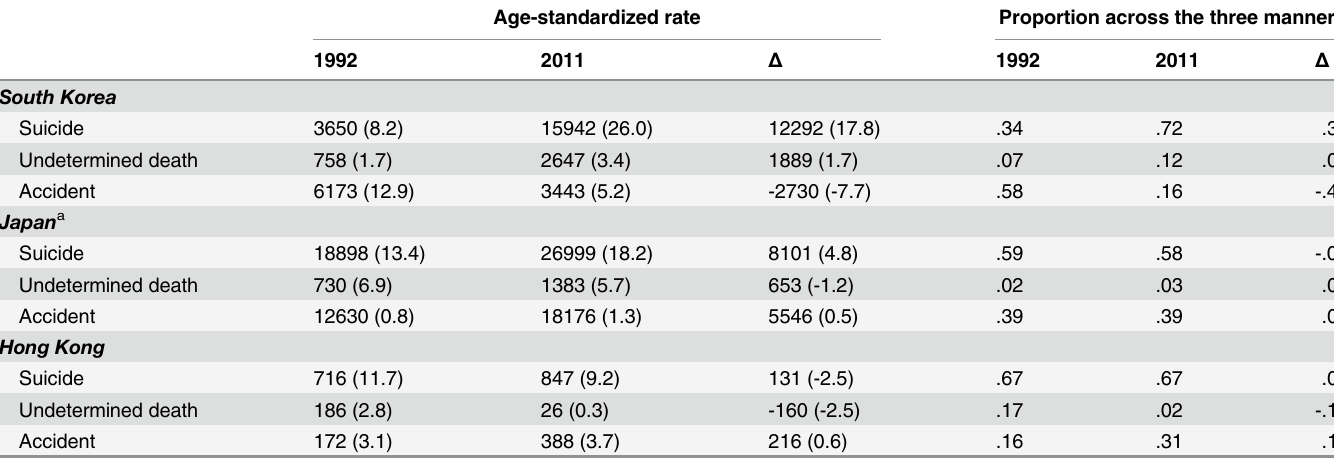
Table 1. The age-standardized rate and proportional change of suicides, undetermined deaths, and accidental deaths from 1992 to 2011. Age-standardized